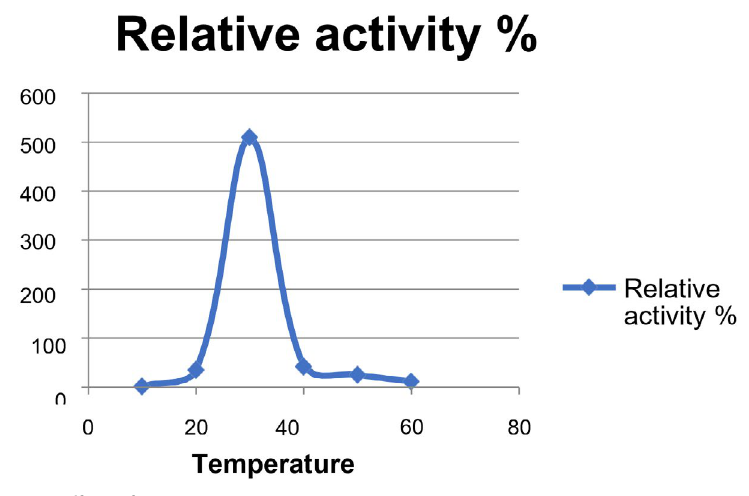
Fig. 4. Effect of temperature on enzyme activity